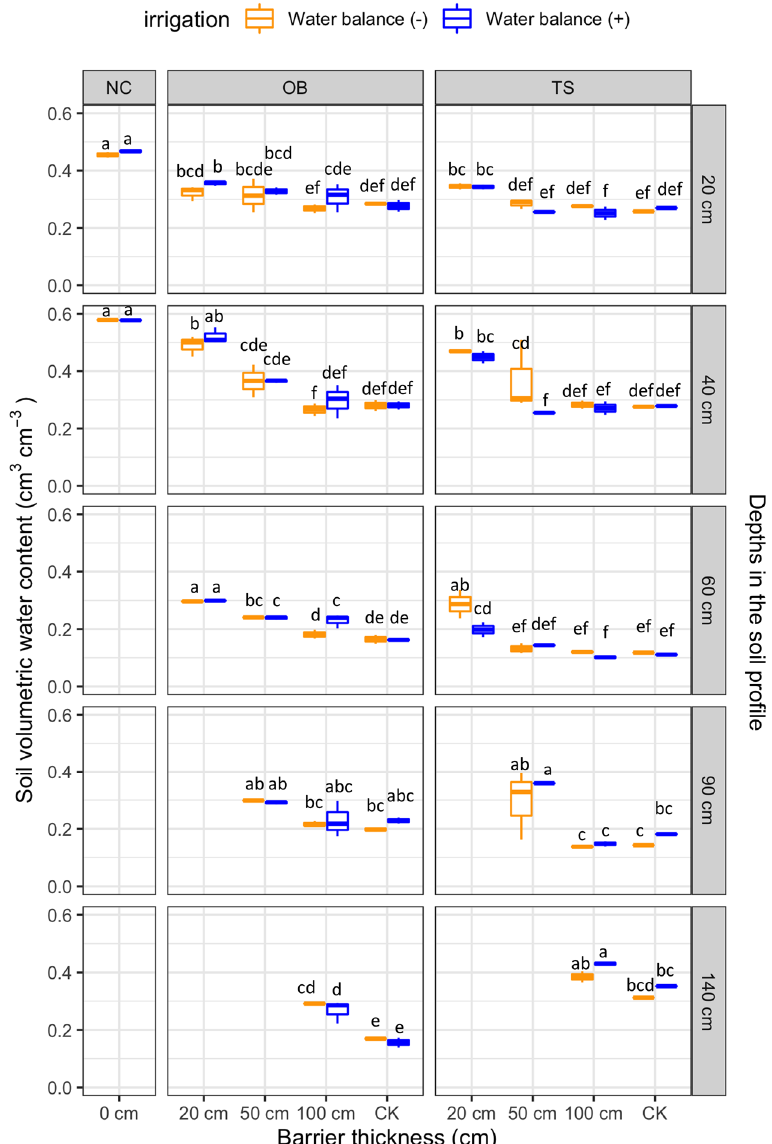
Figure 2. Average soil volumetric water contents in the soil profile during the experiment. Di ff erent letters in a row indicate significant di ff erences ( p < 0.05, ANOVA) among treatments at the same depth, which were derived by comparing all the values across the NC, OB and TS